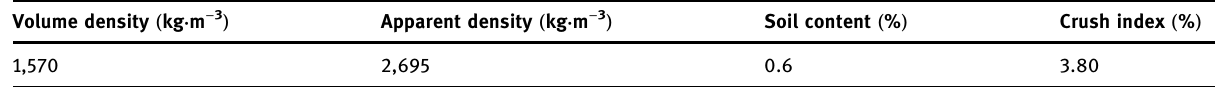
Table 1: Properties of CA